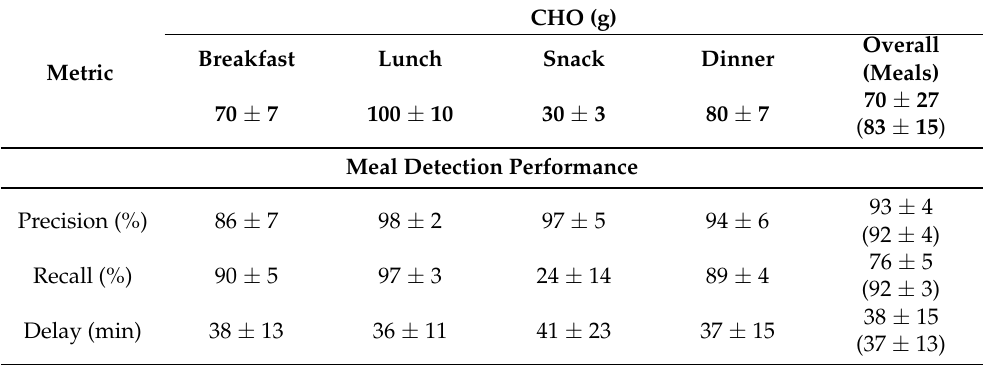
Table 1. Cohort performance metrics for the meal detection performance for the different mealtimes. The meals section involves accounting for algorithm performance without snacks